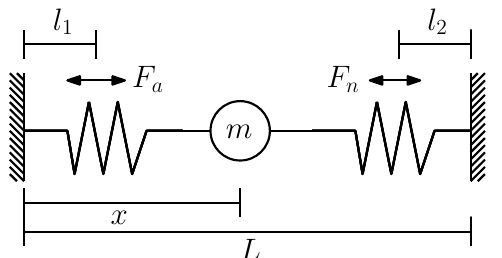
Figure 2. Agonist–antagonist system based on SMA